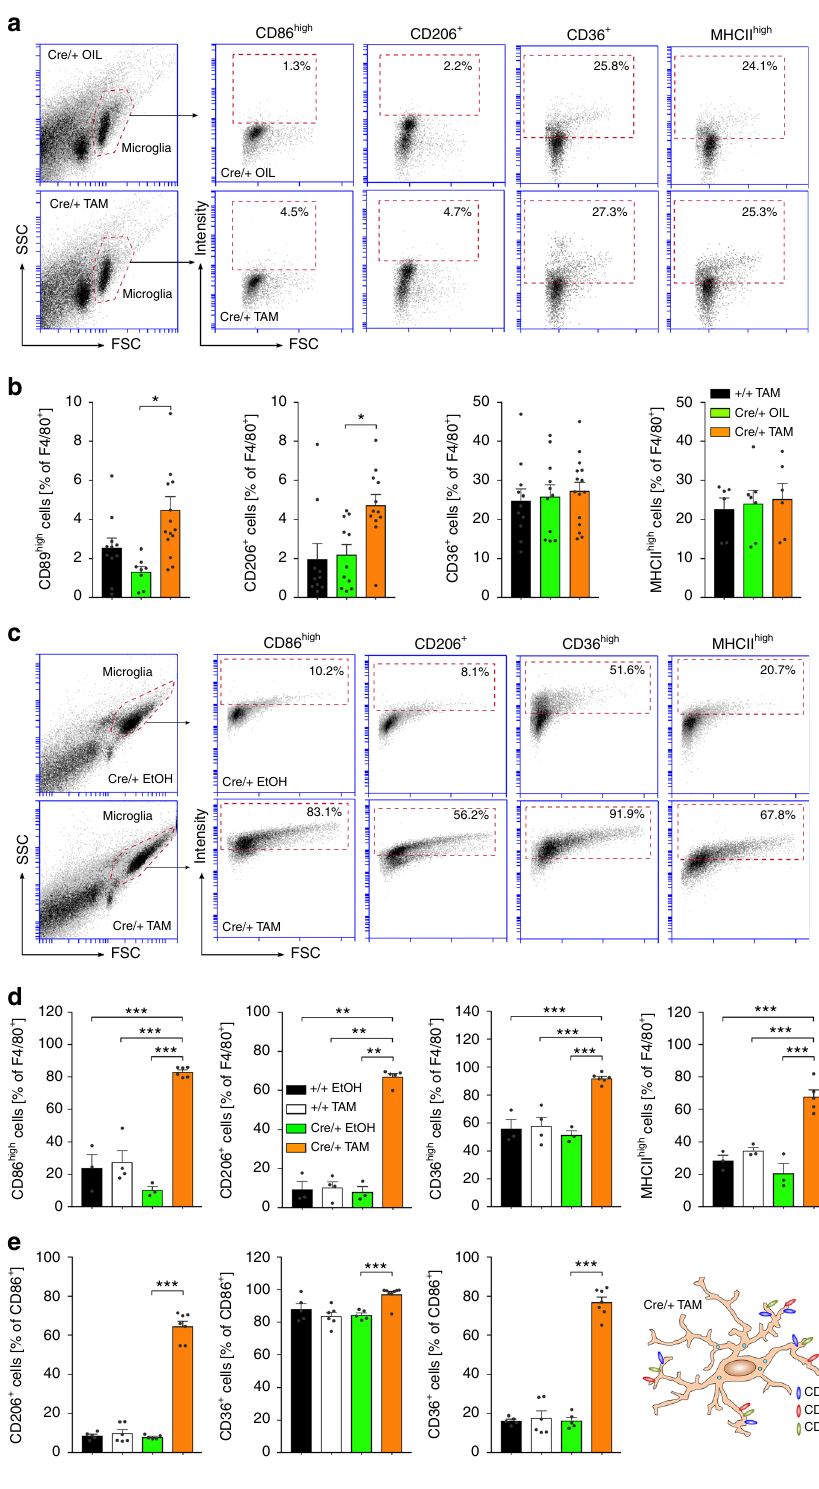
in fl ammatory responses 19 , Butovsky et al. 12 reconstituted per- ipheral TGF β 1 expression under the control of the Il2 promoter resulting in the survival of mice into adulthood. This CNS- speci fi c loss of TGF β 1 lead to a microglia phenotype characterised by loss of microglia-speci fi c gene expression patterns and impaired microglia survival starting from postnatal day 20 12